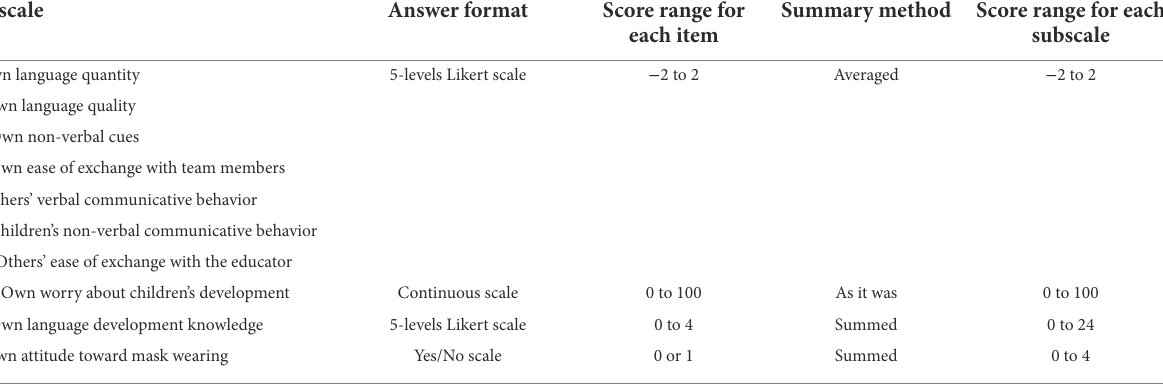
TABLE 2 Summary of indices. Subscale Answer format Score range for